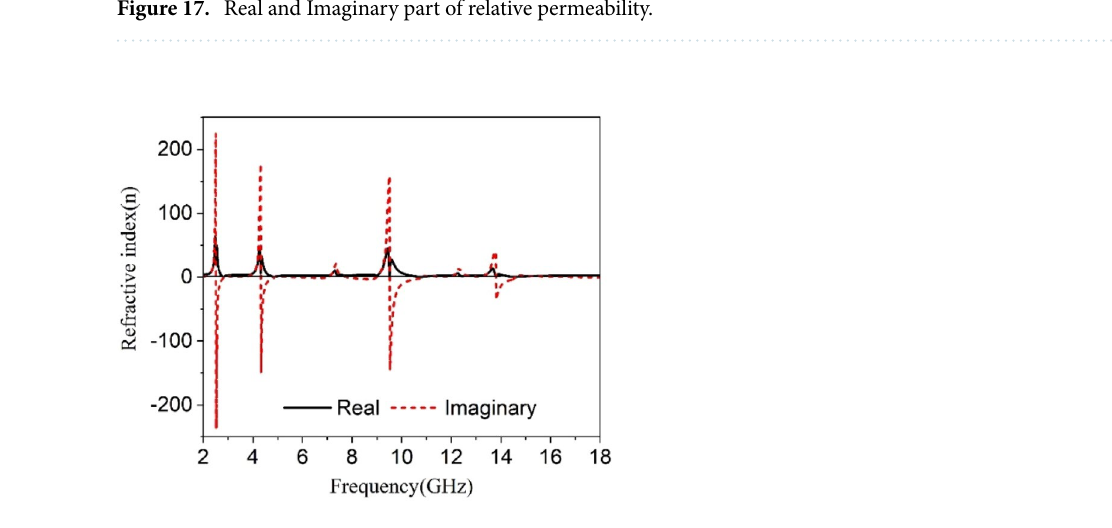
Figure 18. Refractive index of proposed unit cell.